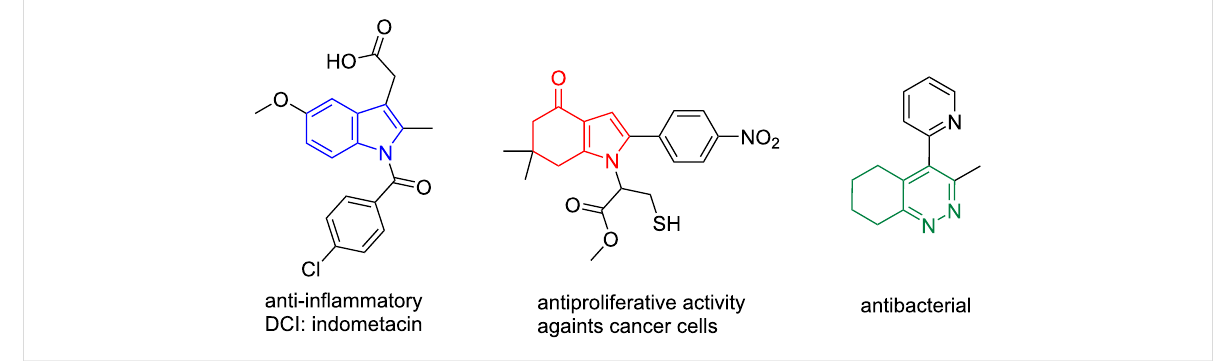
Figure 1: Examples of bioactive nitrogen-containing heterocycles (indole [9], indolone [10], and cinnoline [11] derivatives).